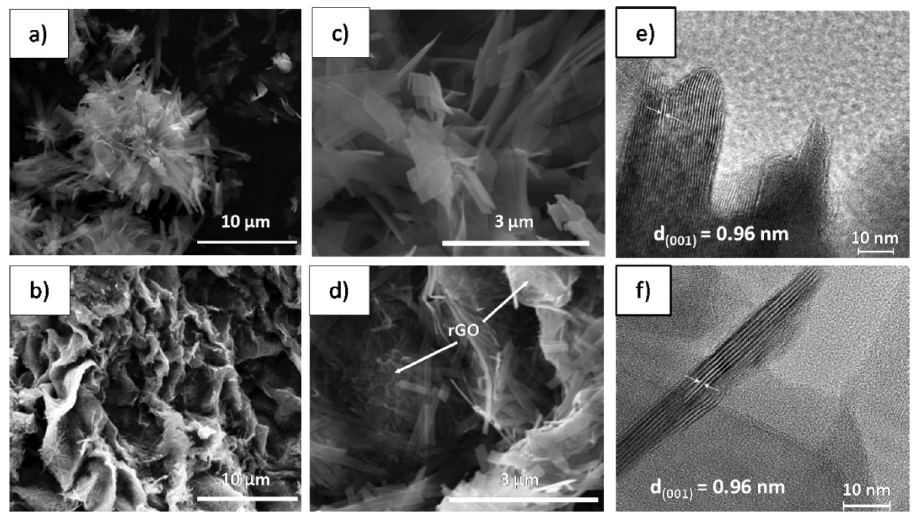
Figure 2. SEM images of NVO ( a , c ) and NVO/rGO ( b , d ) and ( e , f ) high-resolution TEM images of NVO and NVO/rGO, respectively.